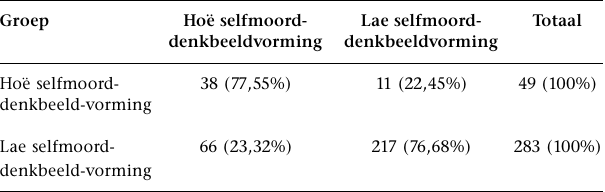
Tabel 7 bevat die klassifikasie van lidmaatskap van hoë/lae selfmoord-denkbeeldvormings-groepe. T ABEL 7